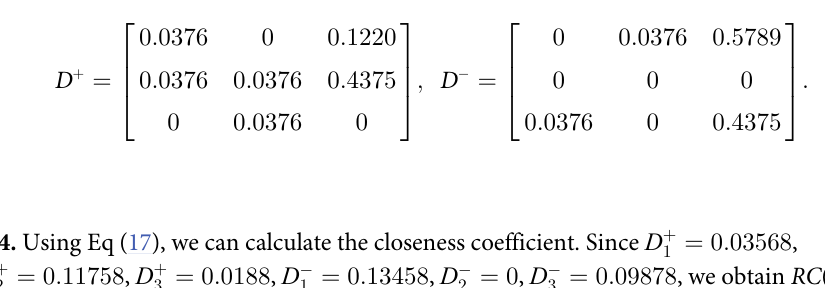
Table 3. Similarity values of D